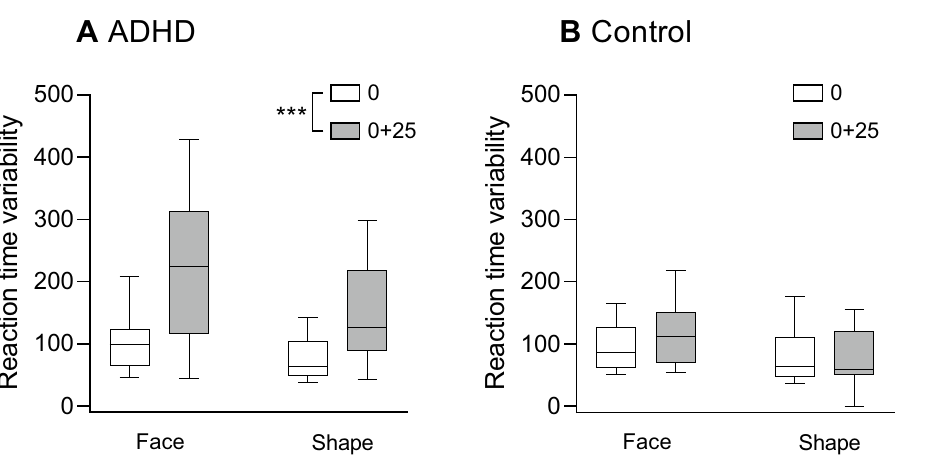
Figure 3. Boxplot (median, minimum–maximum) of the reaction time variability (RTSD) on trials with target faces or target shapes for the ADHD group (A) and the control group (B). Differences between the rates of omission errors before (time 0) and after sleep deprivation (time 0 + 25) were examined across target type for each group using the Wilcoxon signed-rank test. ***p <